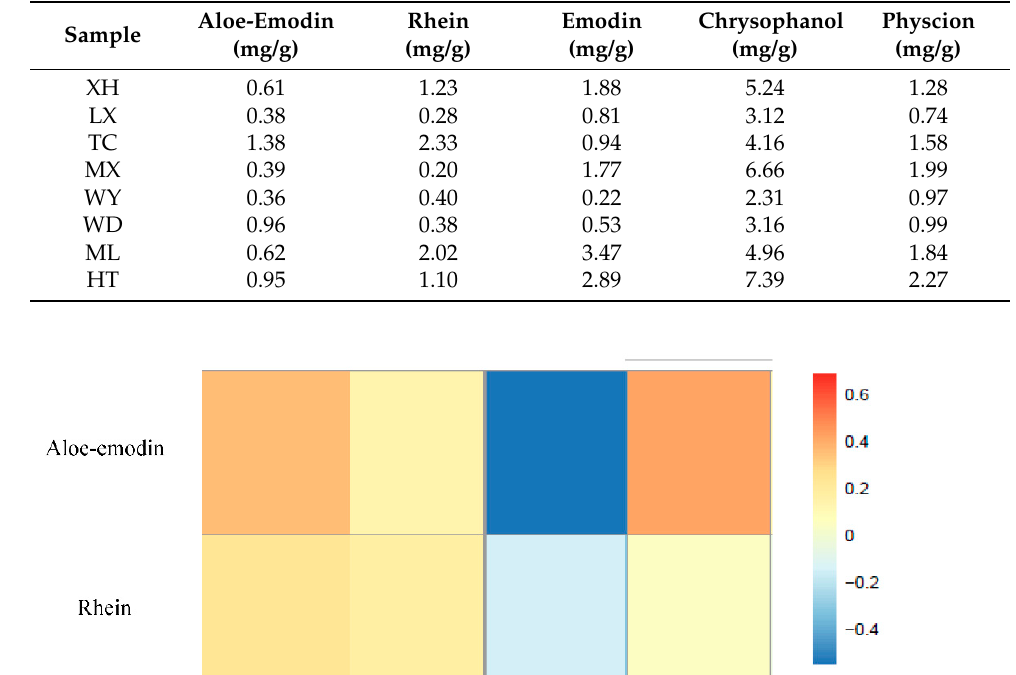
Table 3. Metabolite content of R. palmatum in different production areas.